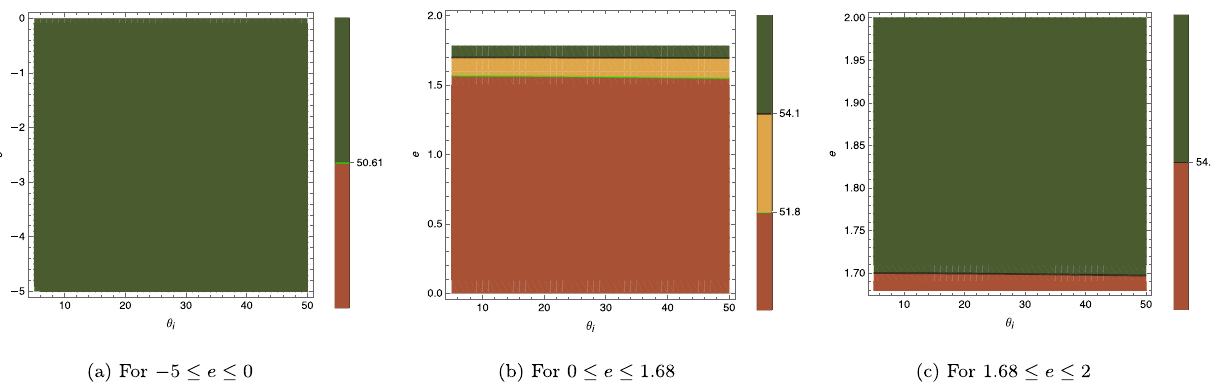
Fig. 5 Contour plots for angular size of Sgr A ∗ shadow if modelled by the metric in Eq. (1). Values of θ i ∈ [ 5 , 50 ] , and e ∈ ( − 5 , 2 ) for which the shadow size is less than 49 . 5 μ as or greater than 54 . 1 μ as are disallowed. Value of b does not effect the shadow